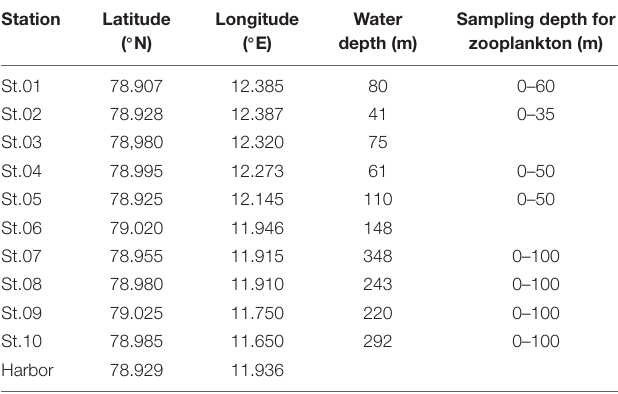
TABLE 1 | Detailed information of sampling